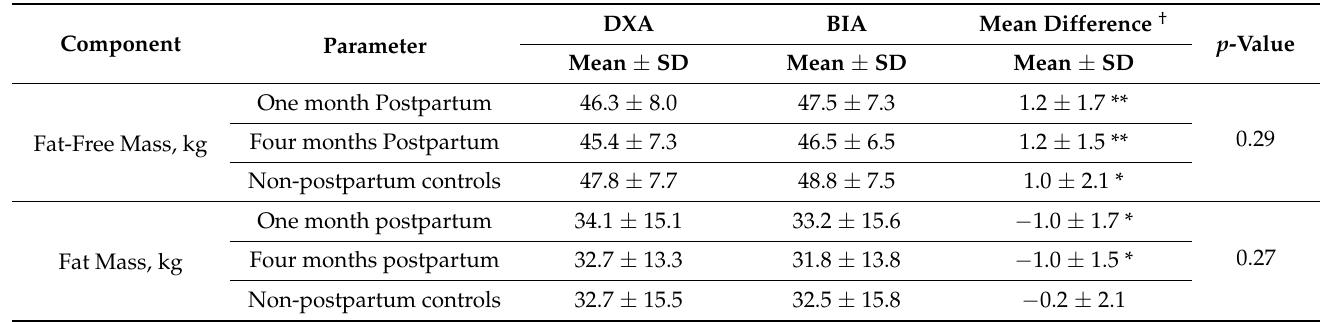
Table 3. Paired t -tests of Mean Difference for Fat-Free Mass and Fat